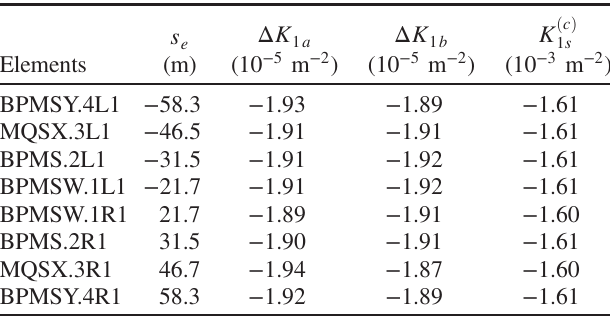
TABLE VII. Corrector strengths calculated from Table VI and Eq. (39).